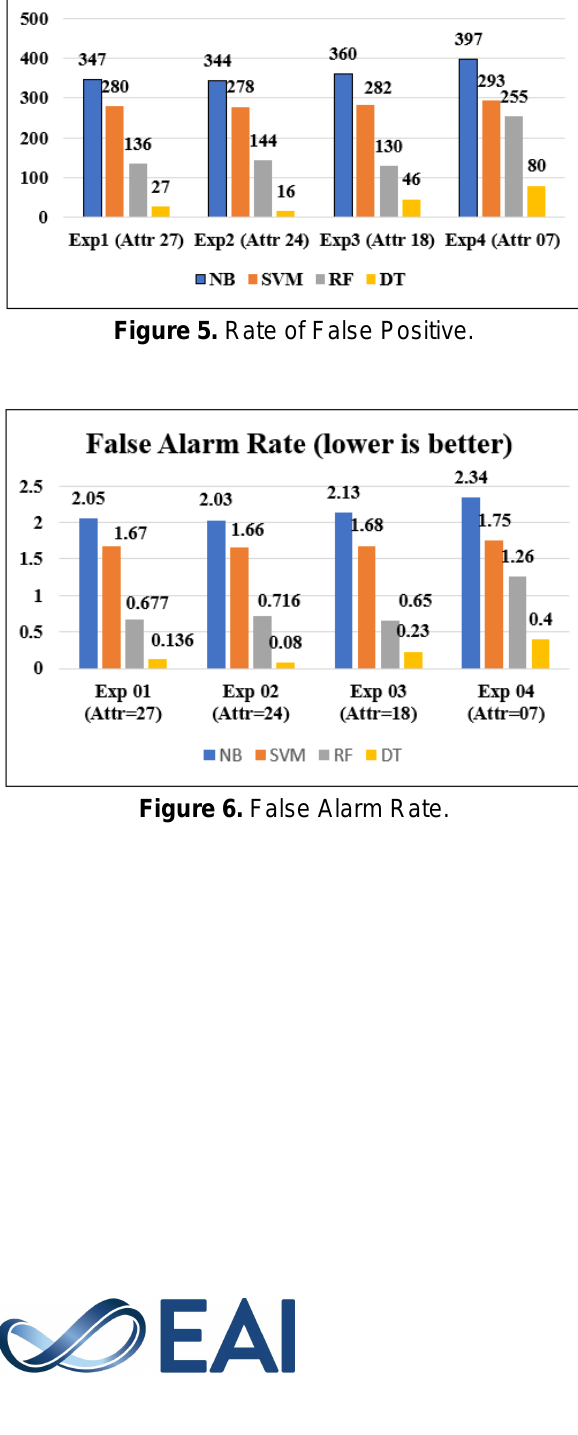
Figure 7. Rate of False Negative.